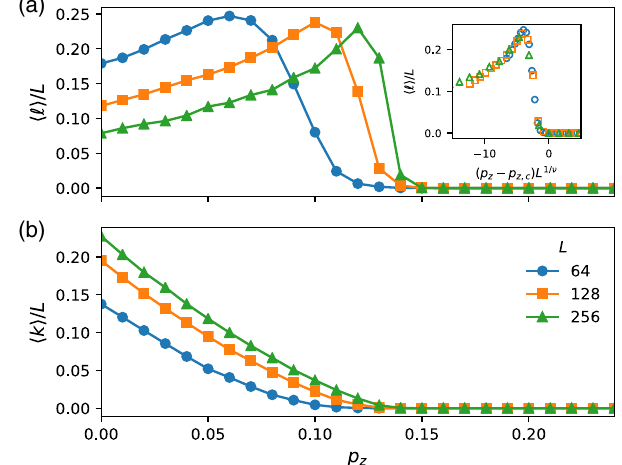
FIG. 9. Quantum code properties of the l -bit ensemble (Ap- pendix A) with range n ¼ 4 and varying probability of Z measurements p (data taken at time t ¼ 4 L ), averaged over at z least 100 realizations. (a) Contiguous code distance, computed as described in the text. The scaling is subextensive deep in the mixed phase and extensive near criticality. Inset: Scaling collapse 0 . 15 and ν ¼ 1 . 1 . (b) Code rate. Both the rate and the with p z;c ¼ 0 distance evolve smoothly from the p z ¼